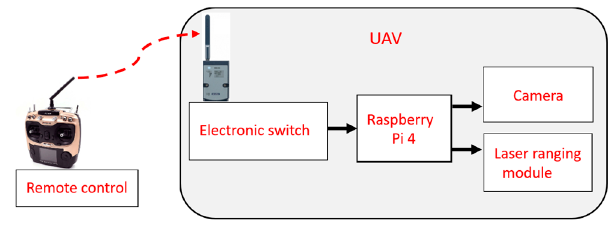
Figure 6. System control signal procedure.